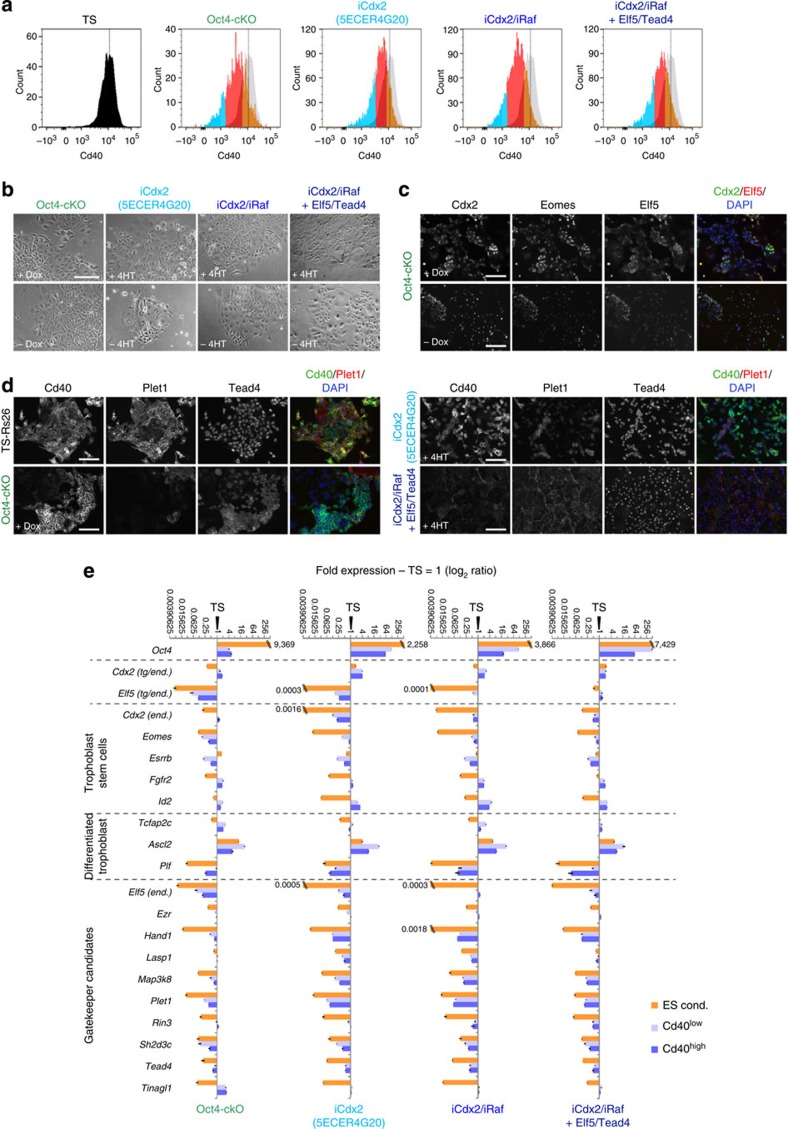
Enrichment for TS-like Cd40-high expressing cells does not select for stably converted iTS cells.(a) Fluorescence-activated cell-sorting strategy based on expression levels of the TS cell surface marker Cd40, as in Fig. 2. Cd40low (cyan) and Cd40high (orange) populations were purified after 6 days of reprogramming on MEFs. FACS profiles of TSL models are overlaid with that of TS cells (grey) and the median TS cell values indicated by the dotted line. Note that Cd40 in TSL models never reaches the Cd40high profile characteristic of genuine TS cells, as shown in Fig. 2g. (b) Phase contrast images of Cd40high cells replated for 7 days in the presence or absence of inducer (Dox or 4HT). Note the overall lack of epithelial integrity. Oct4-cKO cells appeared most TS-like in this system. Scale bar: 200 μm. (c) Cdx2, Eomes and Elf5 triple immunostaining on Oct4-cKO Cd40high-purified cells replated for ~4 weeks indicates loss of co-expression of these core TS cell transcription factors. Elf5 expression was patchy and remained well below that of TS cells. Scale bars: 100 μm (upper row), 200 μm (lower row). (d) Immunostaining for Cd40, Plet1 and Tead4 on Cd40high selected cells as in c. Cd40 expression is lost, in particular in the iCdx2/iRaf+Tead4/Elf5 cells, and is patchy in the other TSL models after this culture period. Plet1 mostly fails to adopt membrane-bound localization at TS-equivalent levels in all models. Scale bars: 100 μm. (e) RT–qPCR survey of trophoblast markers and gatekeeper genes in reprogramming models grown in ES cell conditions as control, and in Cd40high and Cd40low sorted cell populations. Note the persistent imbalance of stable trophoblast gene expression and the failure to adequately downregulate Oct4 in many of these reprogramming models. Values are of three replicates and expressed as mean±s.e.m.